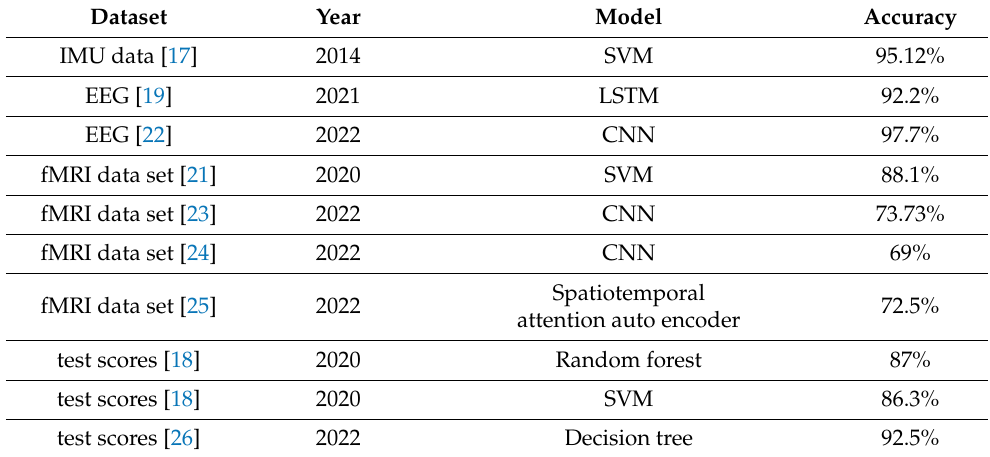
Table 1. Models and accuracy of studies related to ADHD classification using various